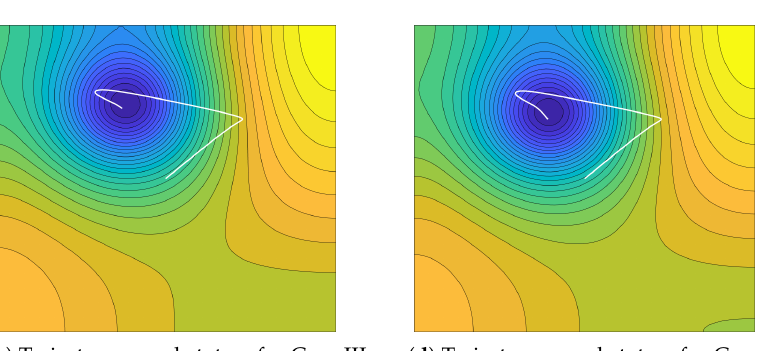
Figure 5. Trajectory γ and state u at T = 4 for the considered four cases with a minimal and a maximal value detailed in Table